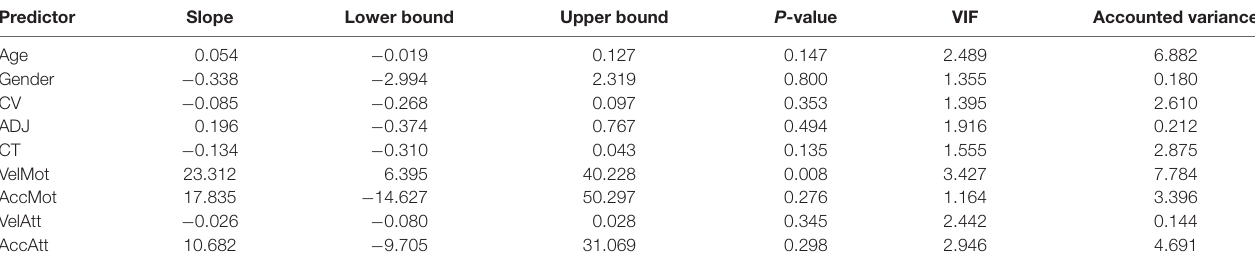
TABLE 1 | Results of the multiple regression analysis (dependent variable = PSE), together with VIF and accounted variance (squares of the partial correlation coefficients ∗ 100). Predictor Slope Lower bound Upper bound P -value VIF Accounted variance Age 0.054 − 0.019 0.127 0.147 2.489 6.882 Gender − 0.338 − 2.994 2.319 0.800 1.355 0.180 CV − 0.085 −